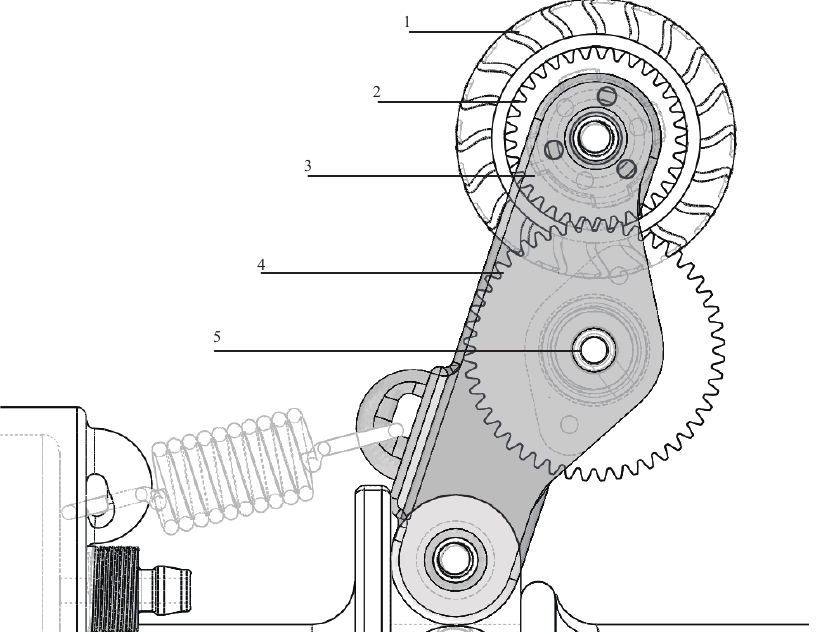
Figure 3. Structure of the odometer wheel module in the distance measurement unit; (1) odometer wheel, (2) active gear, (3) slave gear, (4) support arm, and (5) encoder.